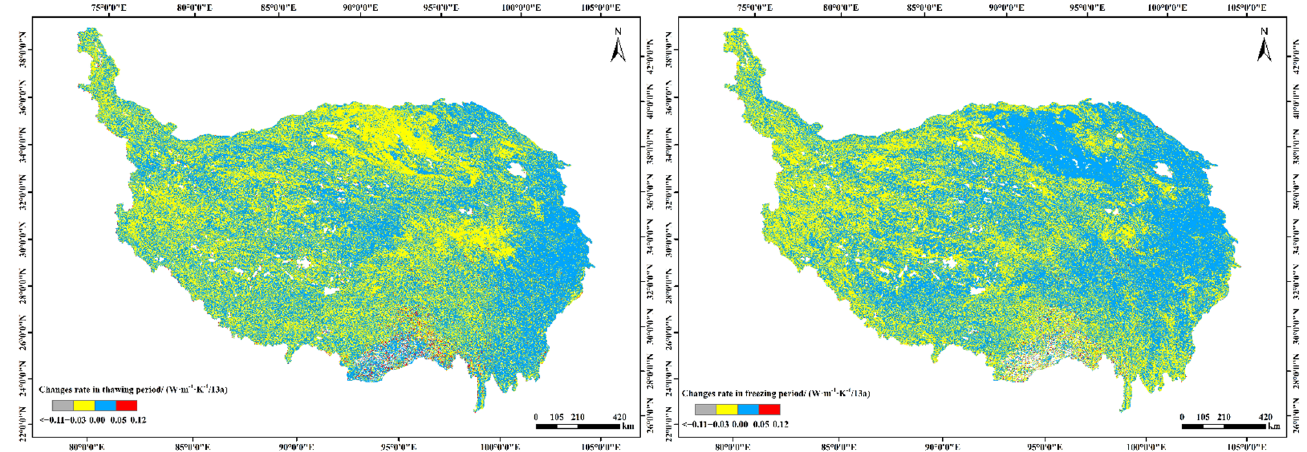
Figure 14. Annual variability characteristics of STC difference value during the thawing ( left ) and freezing ( right ) periods of the Qinghai–Tibet Plateau from 2005 to 2018.